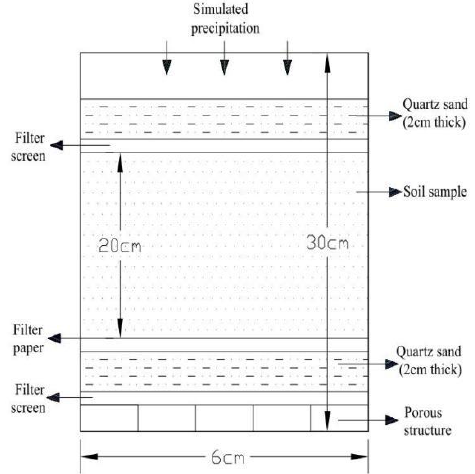
Figure 1. Schematic of PVC column for the soil leaching experiment.